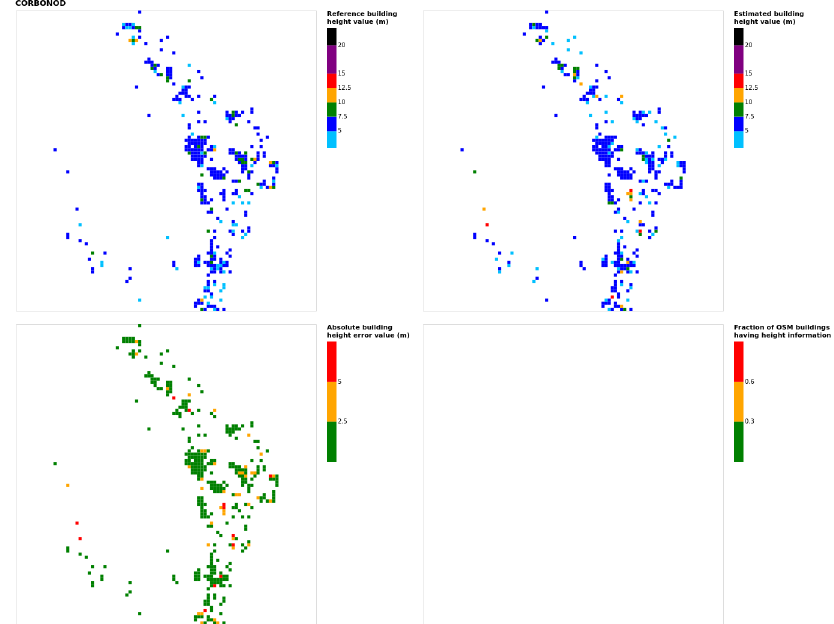
Figure B6. Results for the commune at grid cell (upper left panel) reference building height, (upper right panel) estimated building height, (lower left panel) absolute building height error, and (lower right panel) fraction of OSM buildings that have height information. For all panels except the lower right, only cells that have buildings – with at least 90% of their buildings having no height value in OSM – are